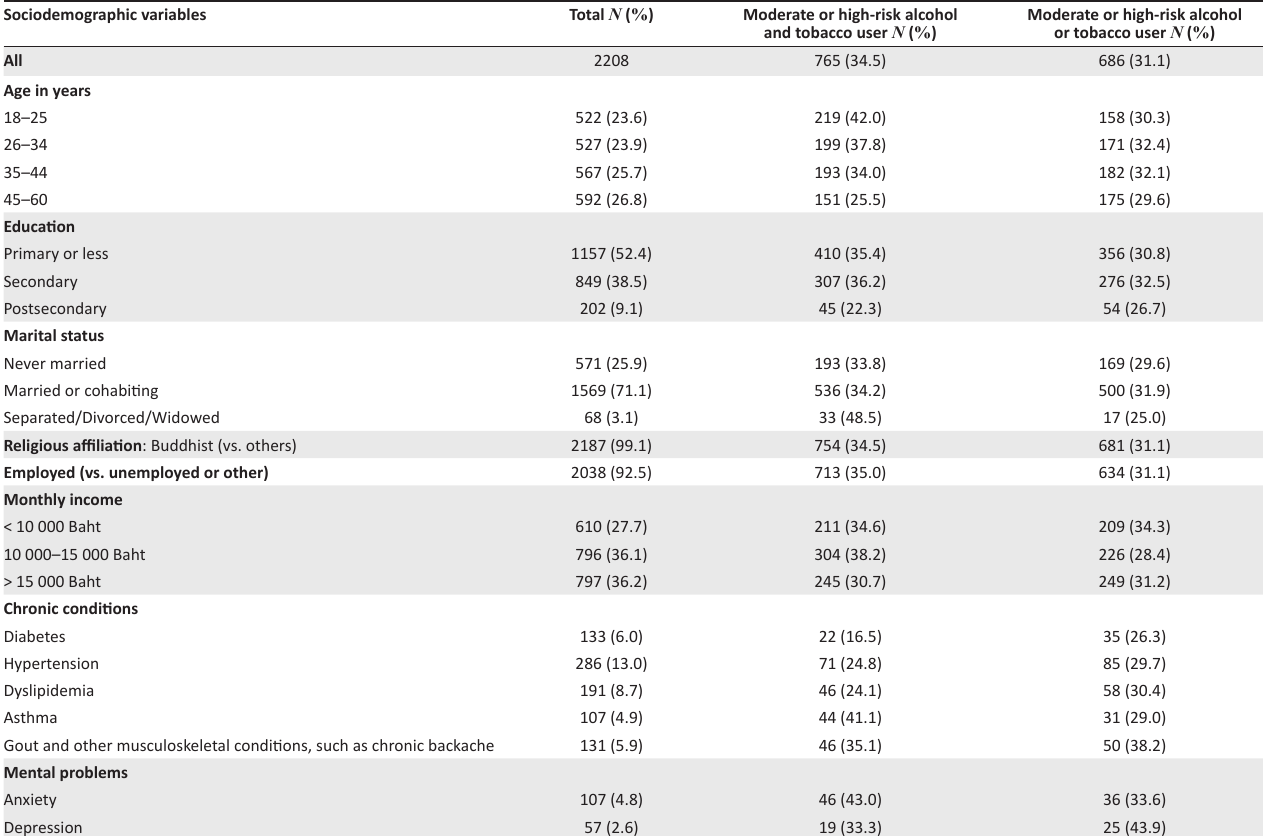
TABLE 1: Sample characteristics, moderate and high-risk alcohol or tobacco use by independent variables in male out-patients, 2014. Sociodemographic